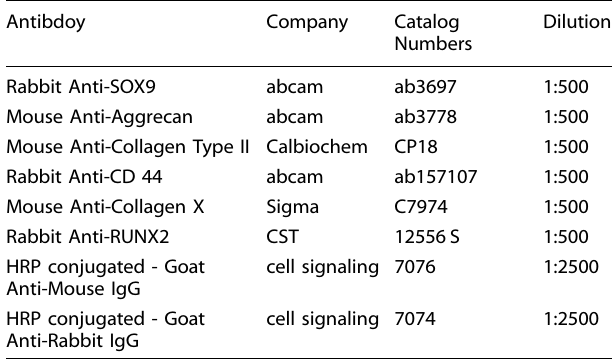
Table 2. Antibodies used for Western Blot